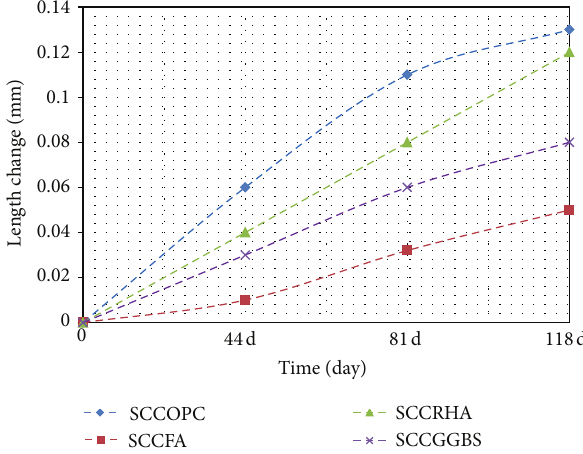
Figure 5: Length affected by the addition of MS and curing ages at SCC.